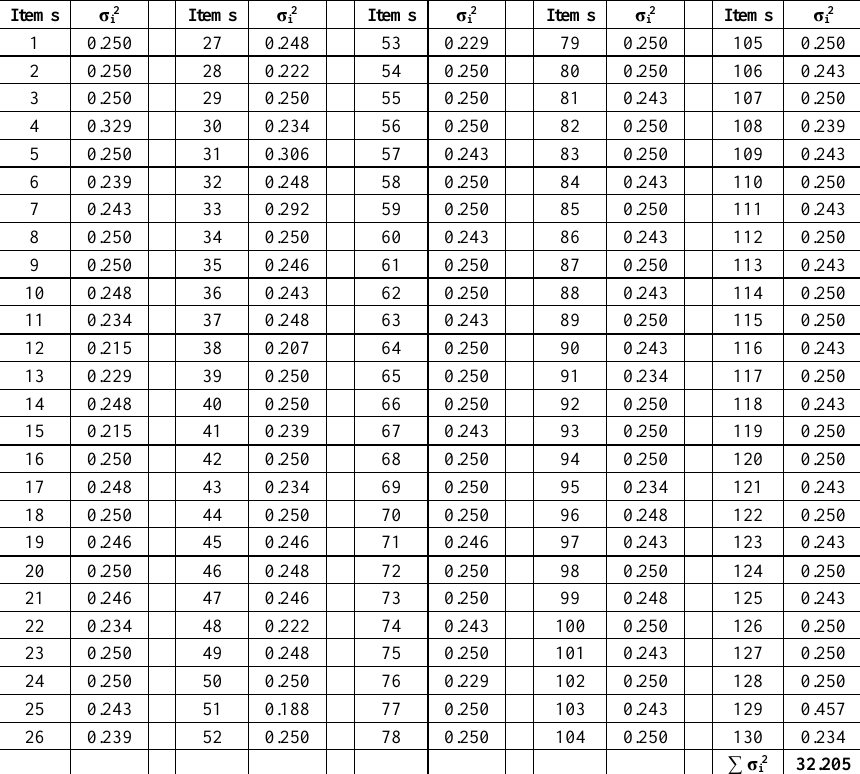
Table 7. Reliability Test Results Data of Tri Kaya Parisudha-Based Countenance Evaluation